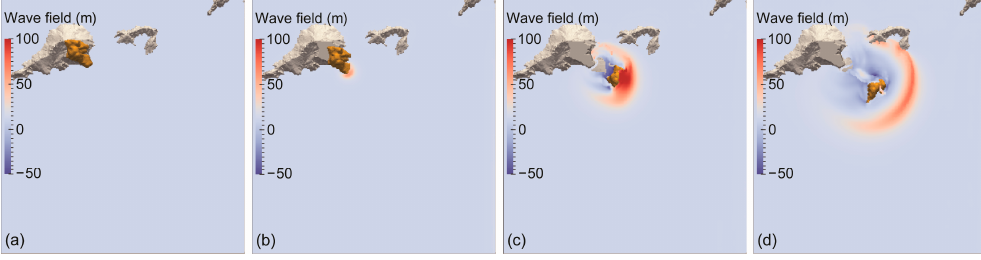
Figure 6. Time history of wave generation in scenario 2 at ( a ) t = − 6.7 s, ( b ) 6.7 s, ( c ) 20.1 s, and ( d ) 33.5 s.